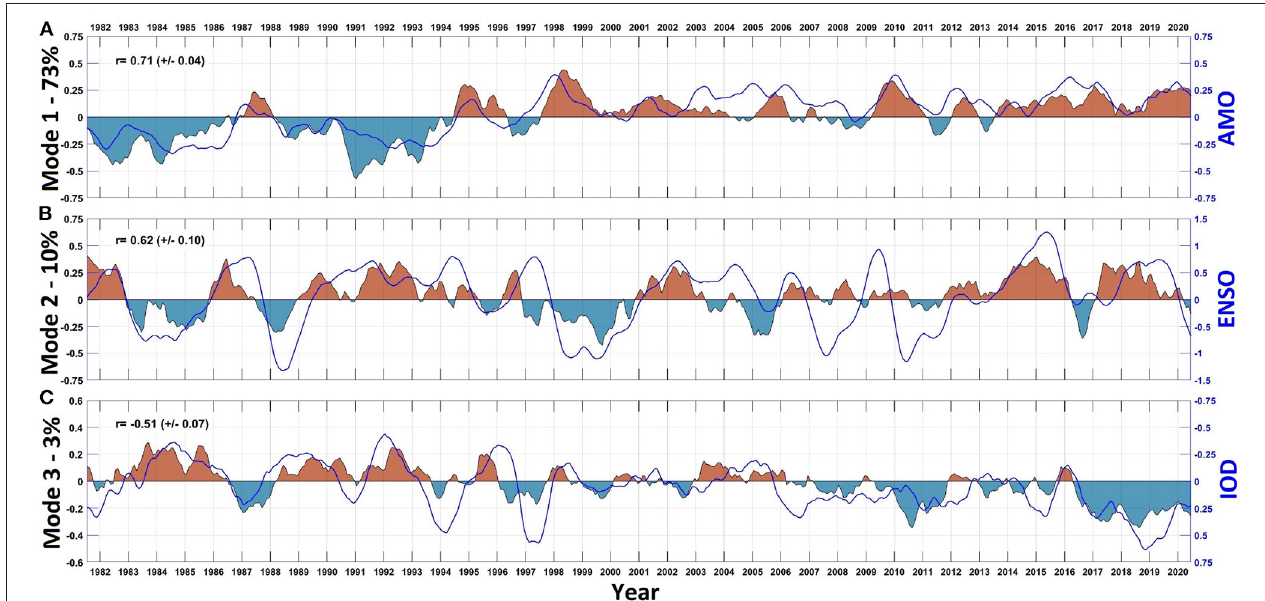
FIGURE 11 | Time series of PC associated with first three modes for 1982–2020 alongside (A) AMO, (B) ENSO, and (C) IOD indices in blue. PC: principal component; AMO: Atlantic Multi-decadal Oscillation; ENSO: El Nio-Southern Oscillation; IOD: Indian Ocean Dipole.